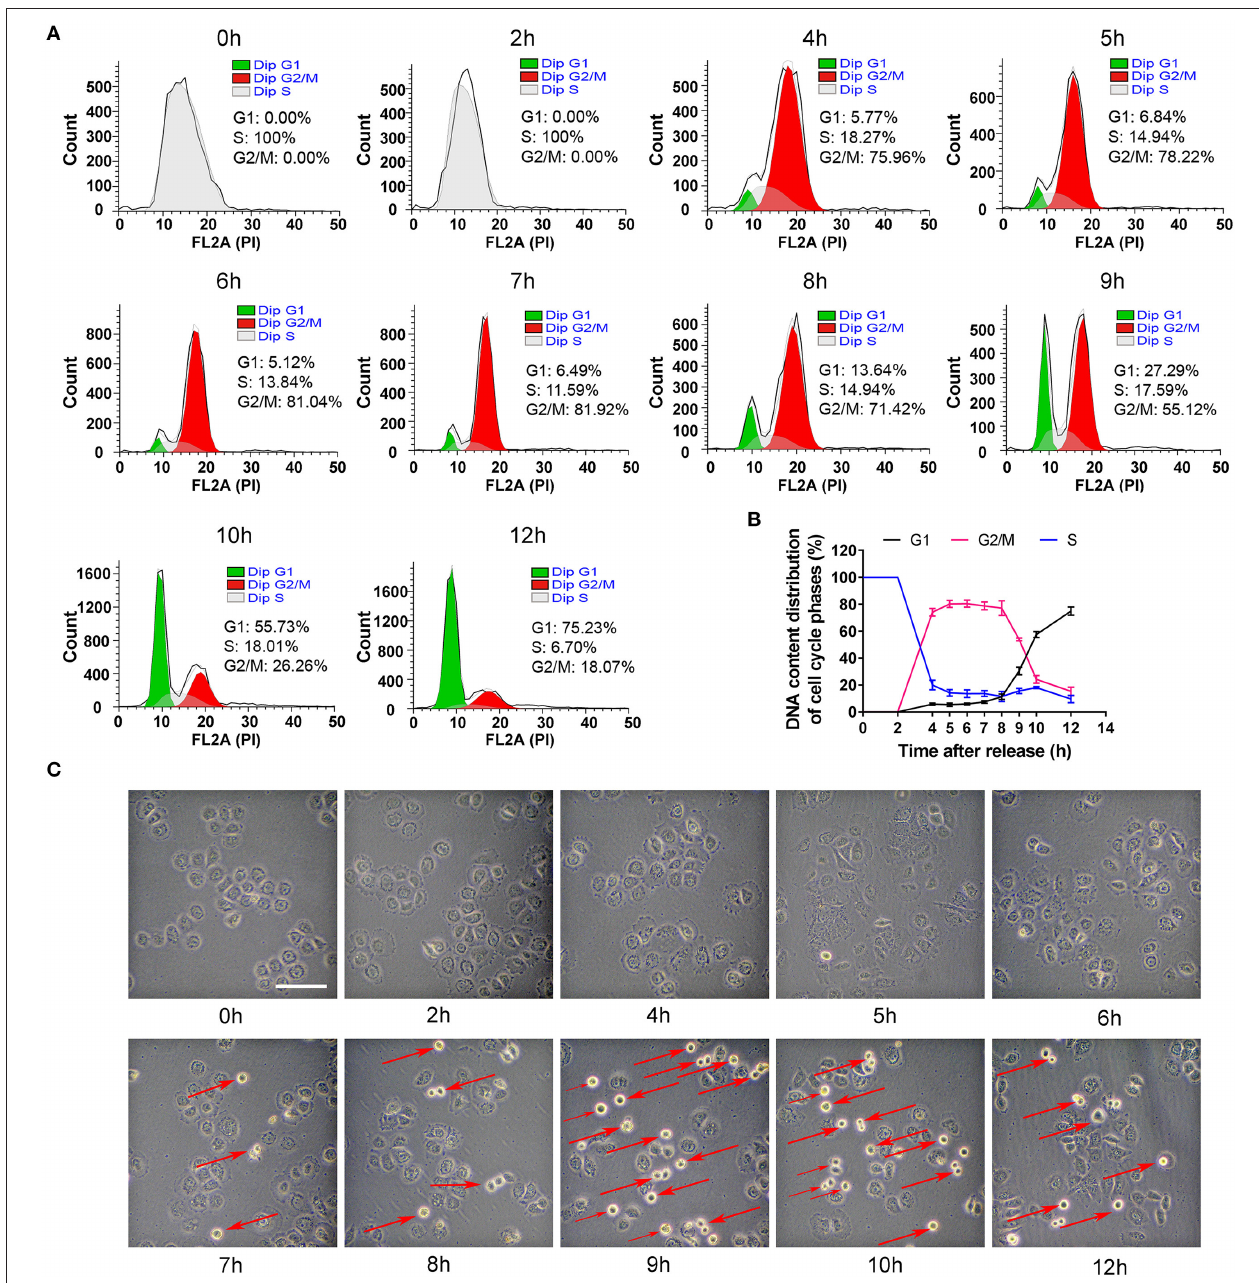
FIGURE 2 | The distribution changes of cells in G2, M and G1 phase after S phase-blocking cells were released. (A) The distributions of cell cycle phases were measured by flow cytometry at indicated time points after releasing from S phase, and the dynamic changes of G1, S and G2/M phases were shown in (B) . All of the values were denoted as the means ± SD; N = 3. (C) Representative photos showed the changes of general morphology of cells at indicated time points. The red arrow marking round cells represents those undergoing mitosis. The scale is 100 µ m.